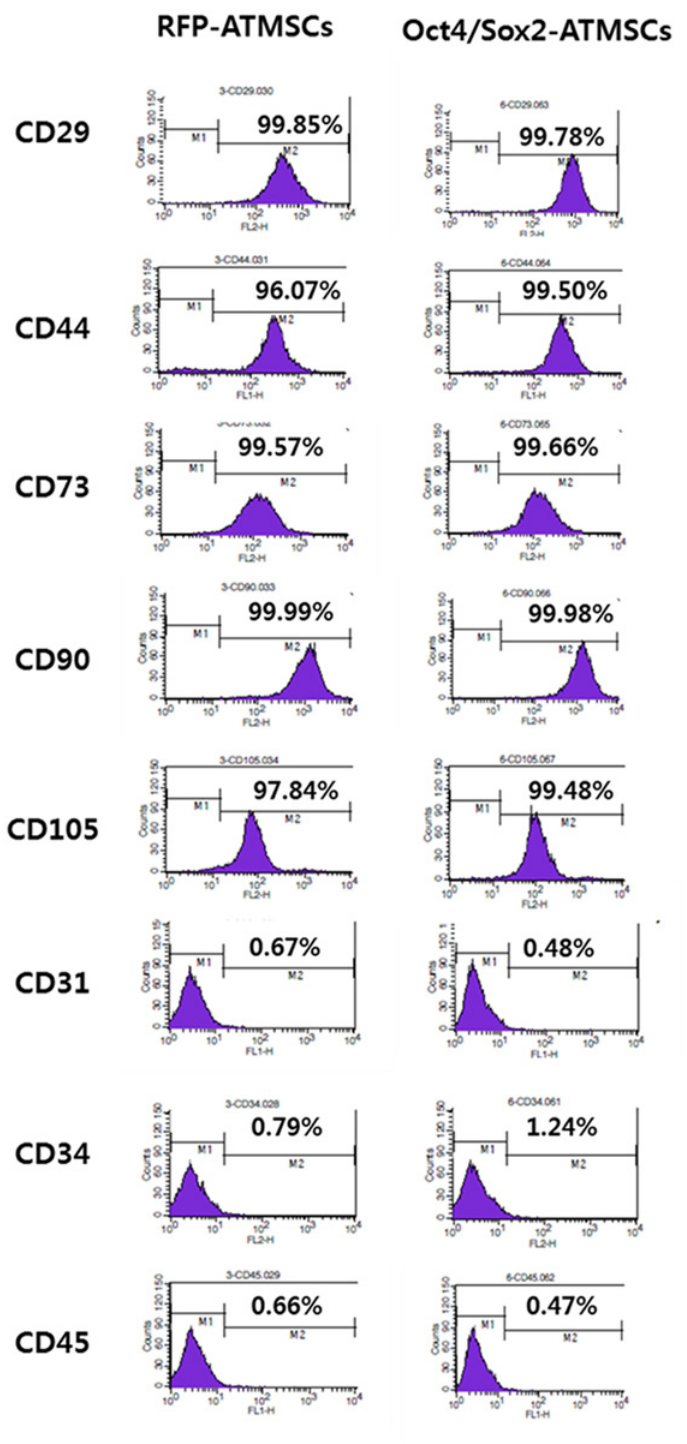
Fig 2. Immunophenotyping of RFP- and Oct4/Sox2-transfected ATMSCs. RFP-transfected ATMSCs and Oct4/Sox2-transfected ATMSCs at passage 5 were immunophenotyped for CD29, CD31, CD34, CD44, CD45, CD73, CD90, and CD105 by flow cytometry. The expression of ATMSC surface markers characteristic of MSCs was maintained.